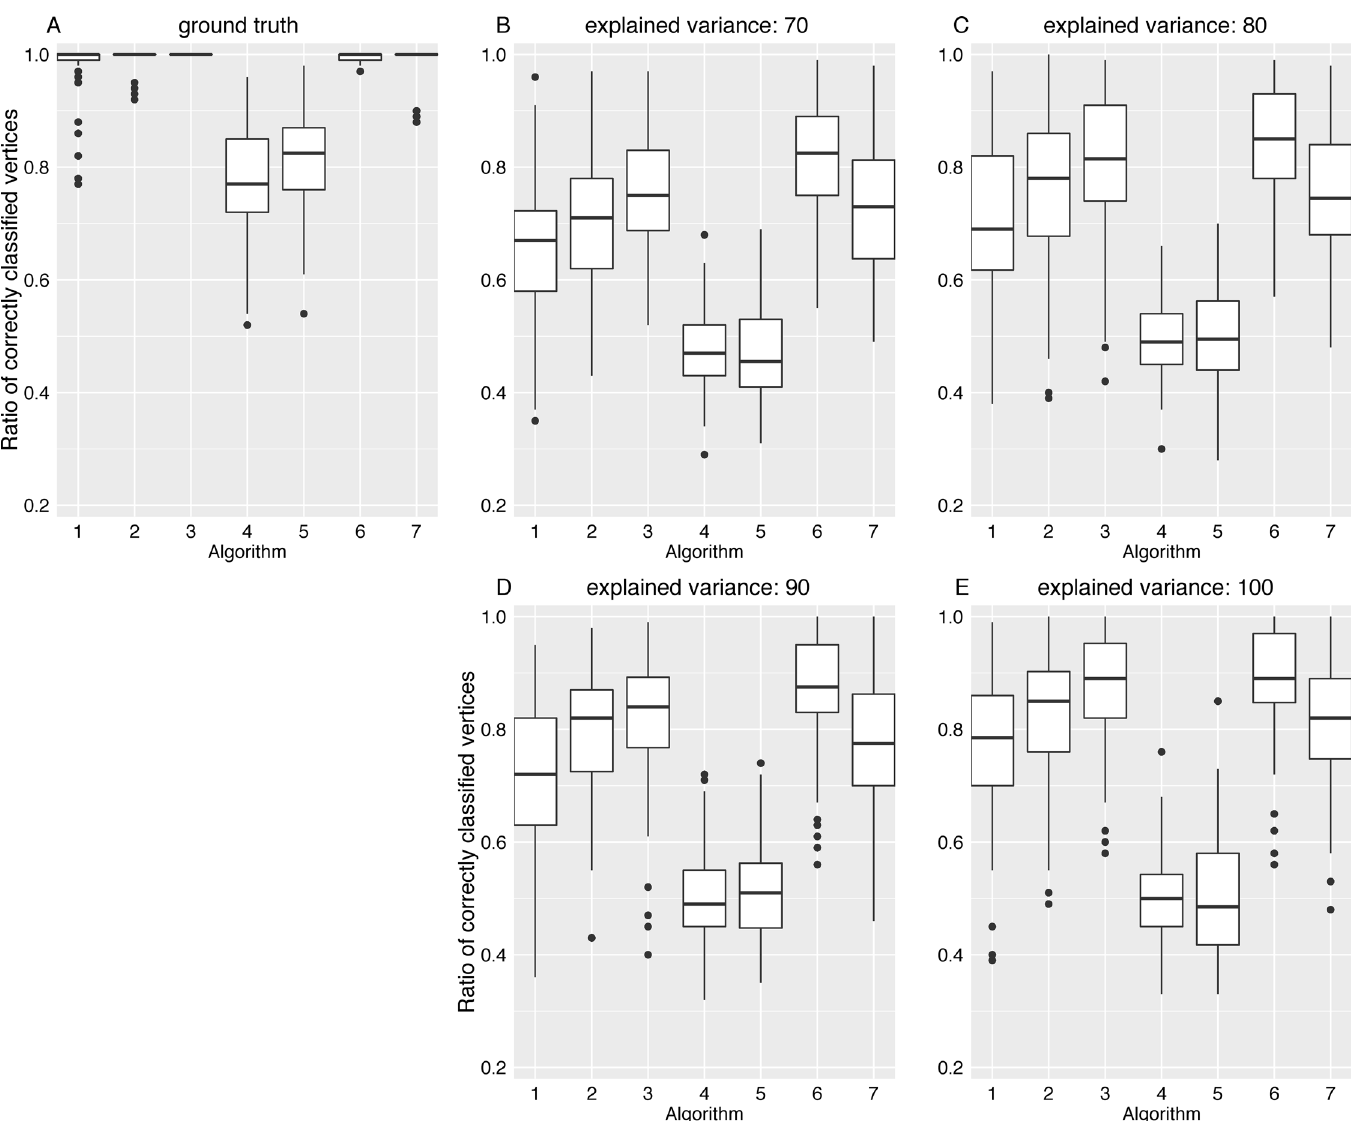
Fig 6. The ratio of correctly classified vertices of the ground truth network and lsGCI networks ( D = 100, N = 1000). The following algorithms for network module identification were used: “ leading eigenvector ” (1), “ Louvain ” directed (2), “ Walktrap ” (3), “ fast greedy ” (4), “ leading eigenvector ” (5), “ Potts spin glass ” (6), “ Louvain ” undirected (7). (A) ground truth network; (B-D) lsGCI network with variance explanations from 70%-90%; (E) GCI